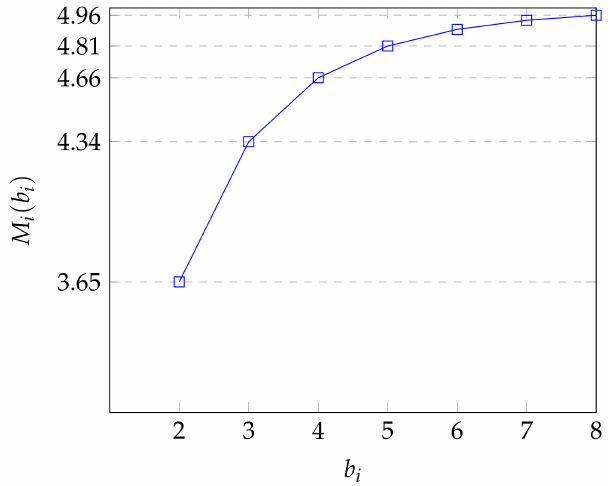
Figure 3. Limit service rate in the node S i for λ i = 3.0, µ i =